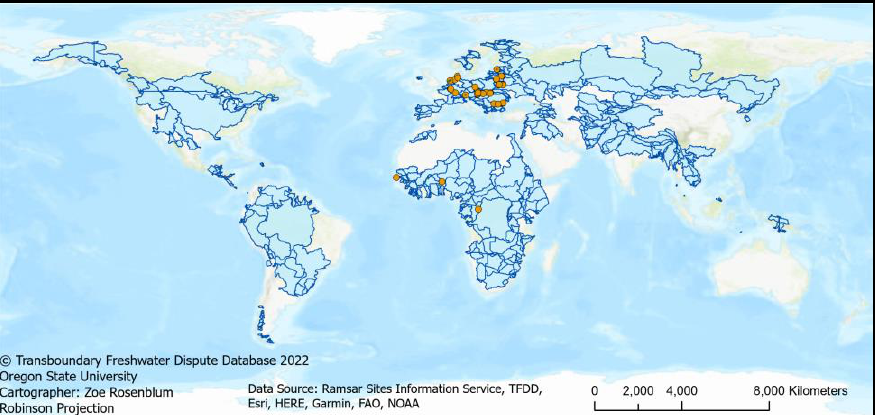
Figure 2. World map with international river basins (blue shading with dark blue outline) and Transboundary Ramsar Sites (orange points). This map was created in ArcGIS Pro using the Ramsar Sites Information Service and the Transboundary Freshwater Diplomacy Database spatial files of 312 international river basins.